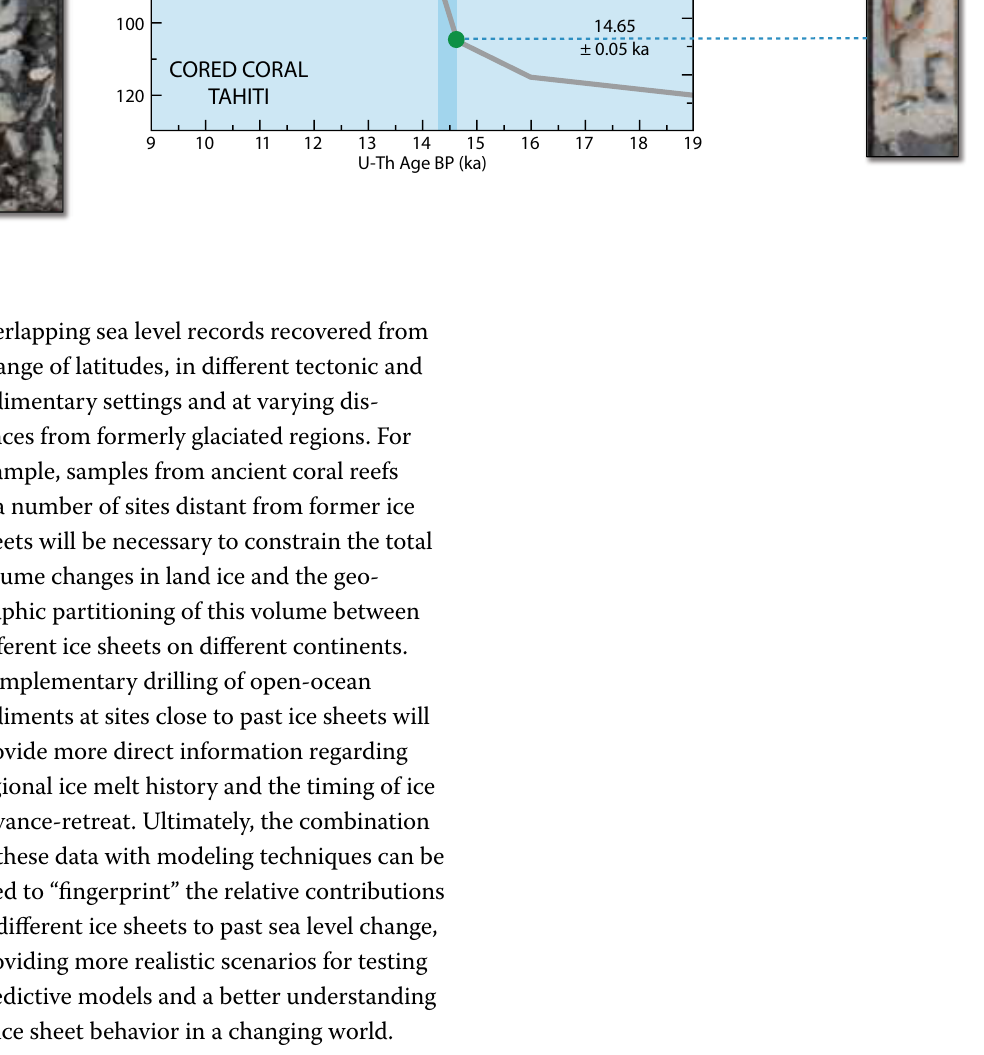
figure 2.7. reconstruction of the relative sea level (m) curve dur- ing the last deglaciation at Tahiti (p. deschamps, cerege, pers. comm ., 2011). The U-series dat- ing of the two reef cores recov- ered during iodp expedition 310 (camoin et al., 2007) demon- strates the coeval occurrence at 14.65–14.60 thousand years ago of meltwater pulse 1a (dark blue) and the dramatic high-latitude warming associated with the inception of the Bølling- allerød (B, a) warm period (air temperature data shown from the ngrip ice core from greenland). The older dryas (od) and the younger dryas (yd) cooling events recorded in the ice cores are also